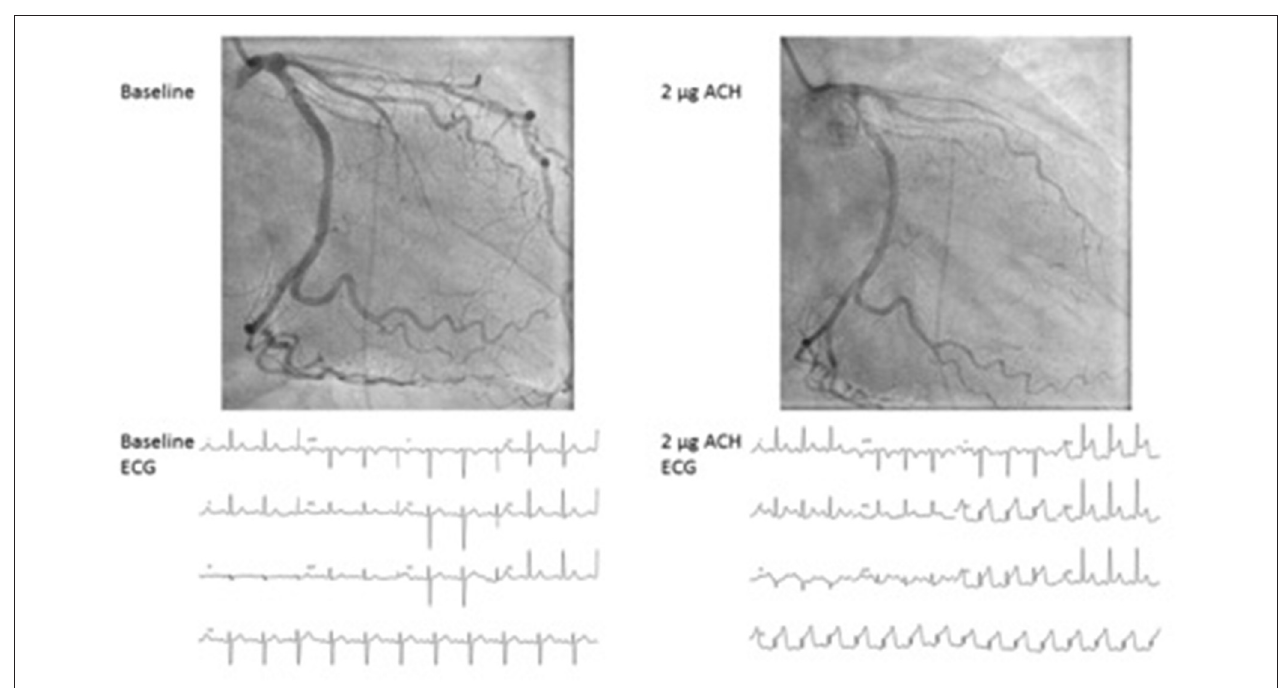
FIGURE 1 | Epicardial spasm provoked by acetylcholine during coronary vasomotor test. Case of a 46-year-old female with severe chronic angina. At 2 mcg of acethylcholine a severe spasm of the LAD occurs with concurrent severe angina and ST elevation at the ECG. ACH, Acetylcholine; ECG, electrocardiogram.